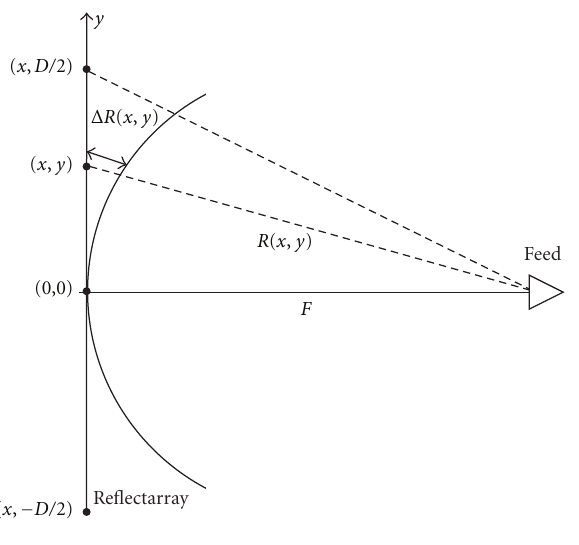
Figure 1: Reflectarray geometry.